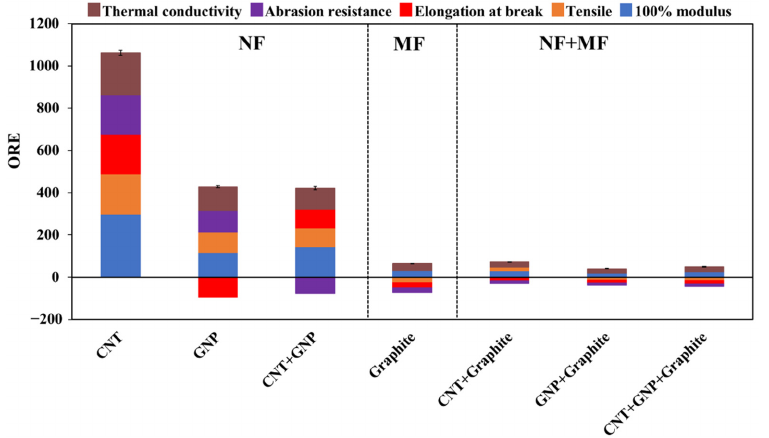
Figure 6. The overall R\relative E\efficiency (ORE) values of the various studied combination of fillers (see composition in Table 3). The color code indicates the contribution of the different properties (as in Figures 3–5). The dashed lines separate the nano-size filler (NF), micron-size filler (MF), and their combination (NF + MF).